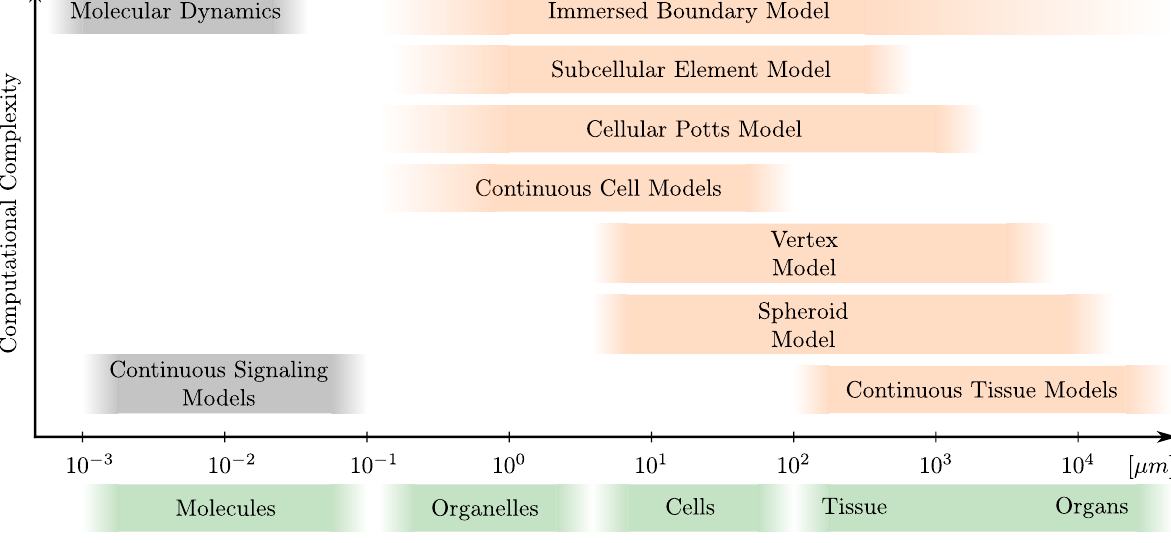
Figure 2. Scales and modelling approaches of signalling ( Grey ) and tissue modelling approaches ( Red ). On the horizontal axis, typical length scales are given. The vertical axis indicates increasing computational